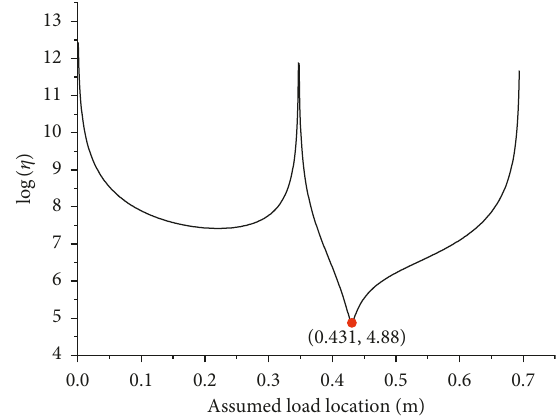
Figure 18: The optimization function value of impact